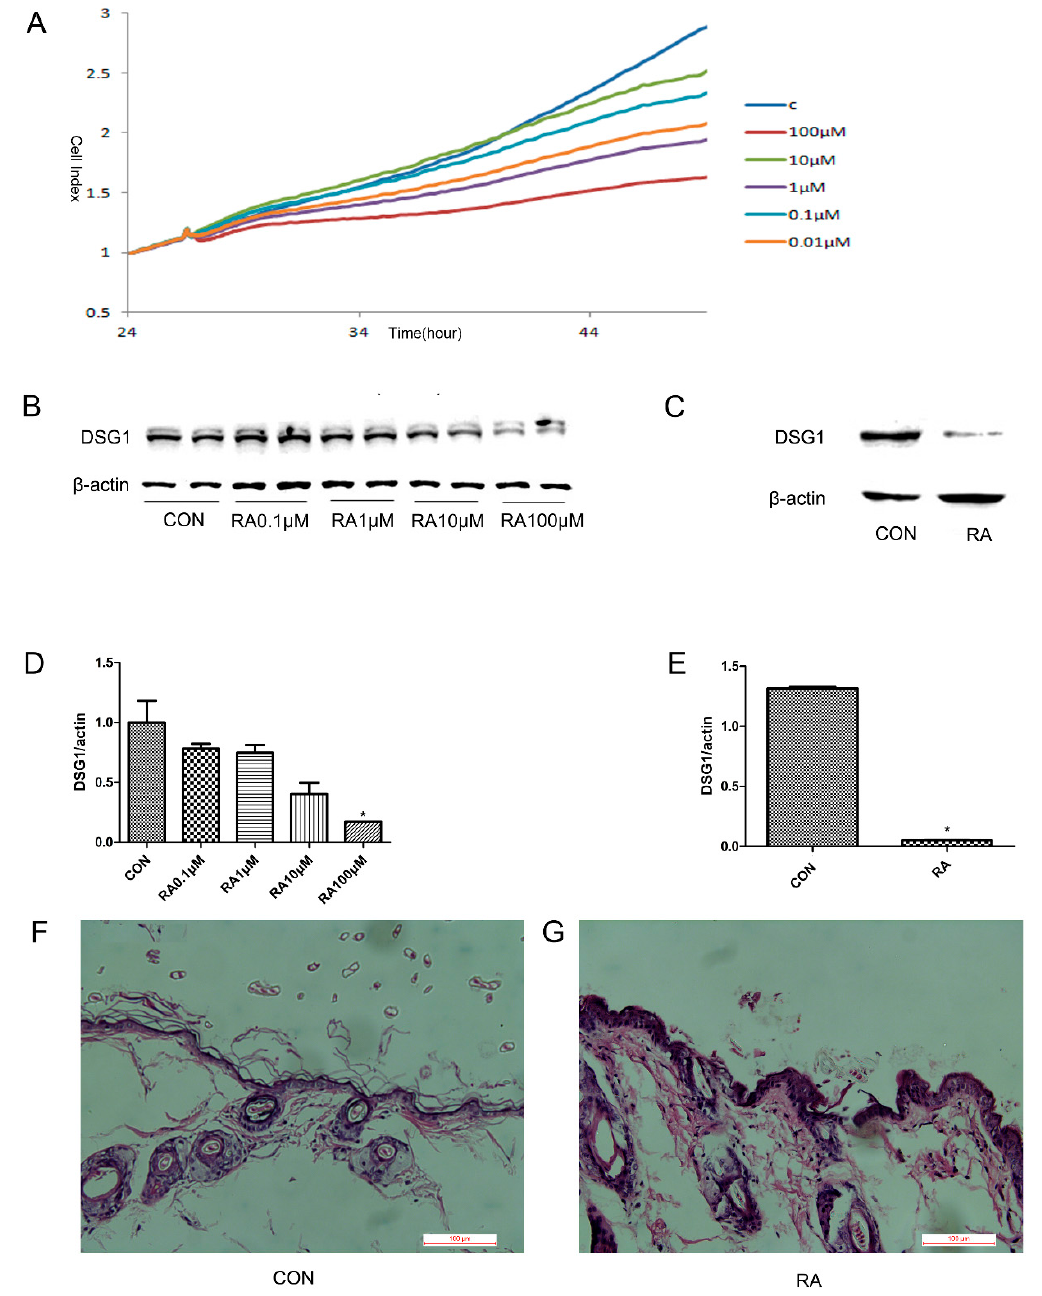
Figure 1. RA downregulated the expression of DSG1 in vitro and in vivo. ( A ) Effects on the Hacat cells index treated with different concentrations of RA (0.01 µ M, 0.1 µ M, 1 µ M, 10 µ M, and 100 µ M). ( B , D ) RA (0.1 µ M, 1 µ M, 10 µ M, and 100 µ M) downregulated the DSG1 expression in the Hacat cells. ( C , E ) RA (70 mg/kg) downregulated the DSG1 expression in Hacat cells by Western blot. ( F , G ) Pathology changes of the skin tissue (HE staining) in mice skin. Data are presented as mean ± S.D, * p < 0.05 vs. control.